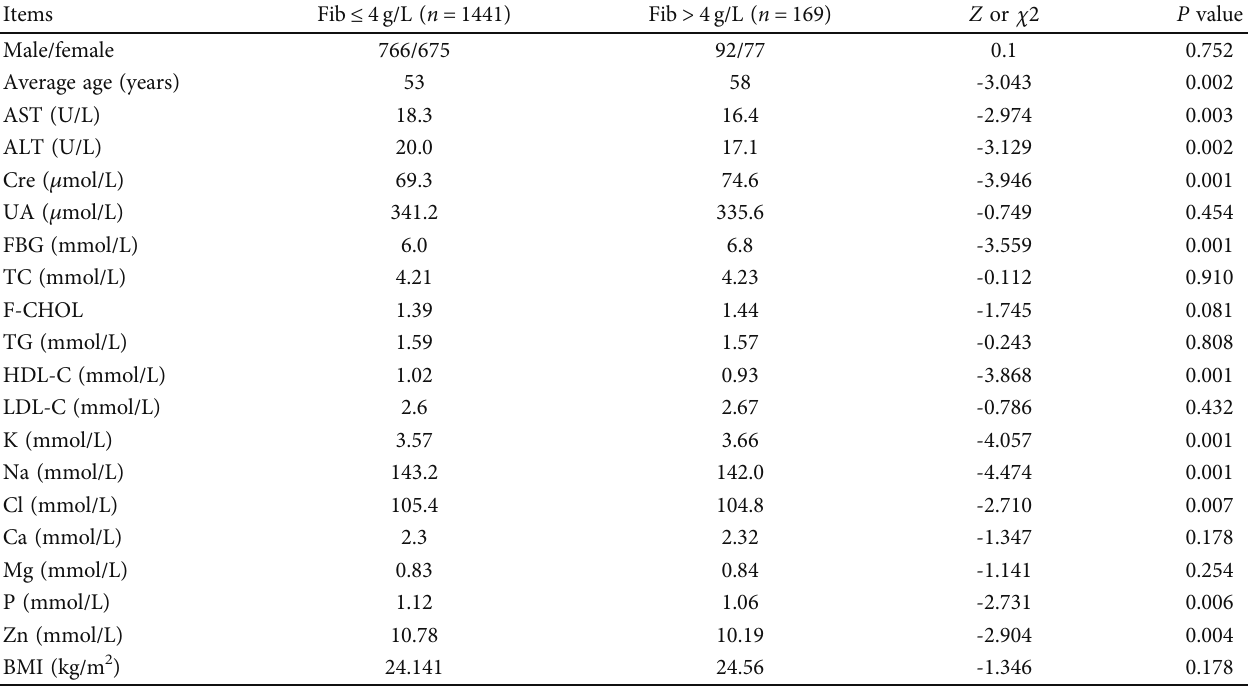
Table 5: Comparison of clinical data of patients in the Fib ≤ 4 g/L and Fib > 4 g/L